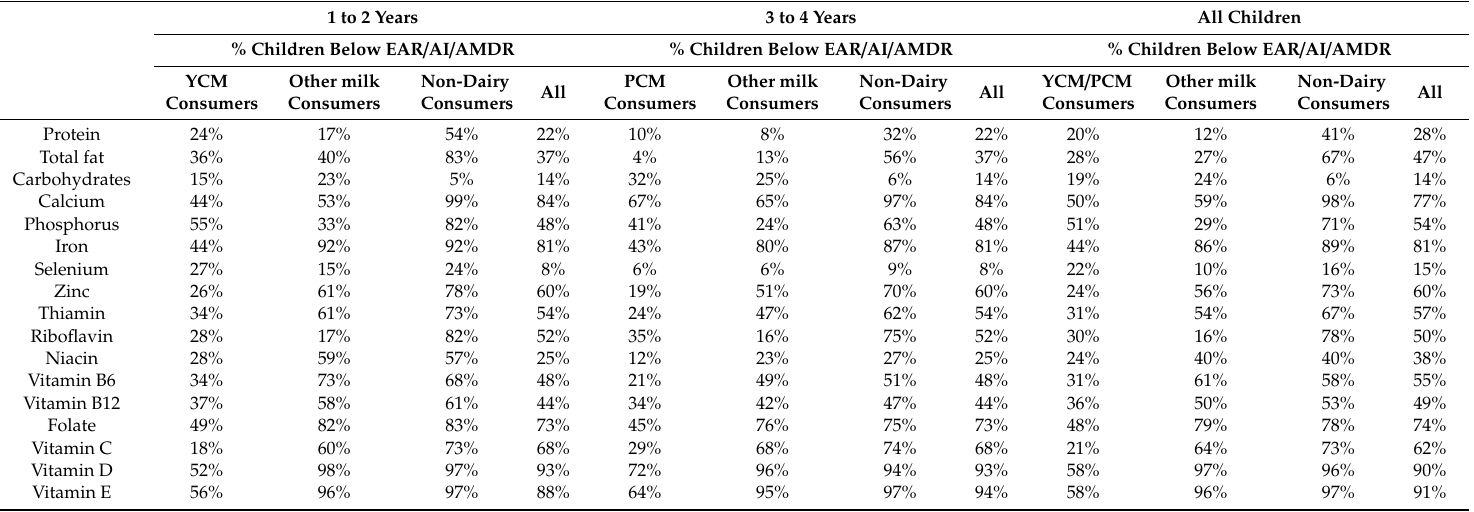
Table 3. Percentage of children with inadequate intakes per consumer group by age groups one to two years, three to four years, and all